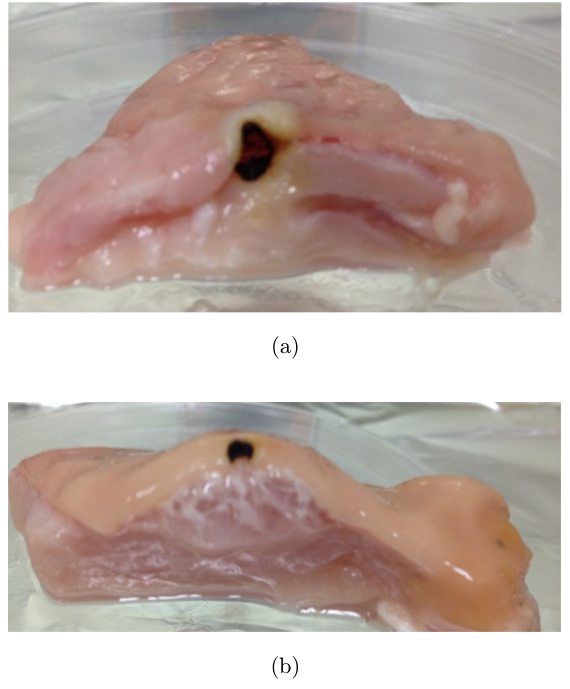
Fig. 8. Cross-sectional views of the perforated stomach tissue samples (a) without SFC insertion and (b) with SFC insertion after laser irradiation at 5 W for 30 s. A methyl blue solution of 1% concentration was used for the SFC.